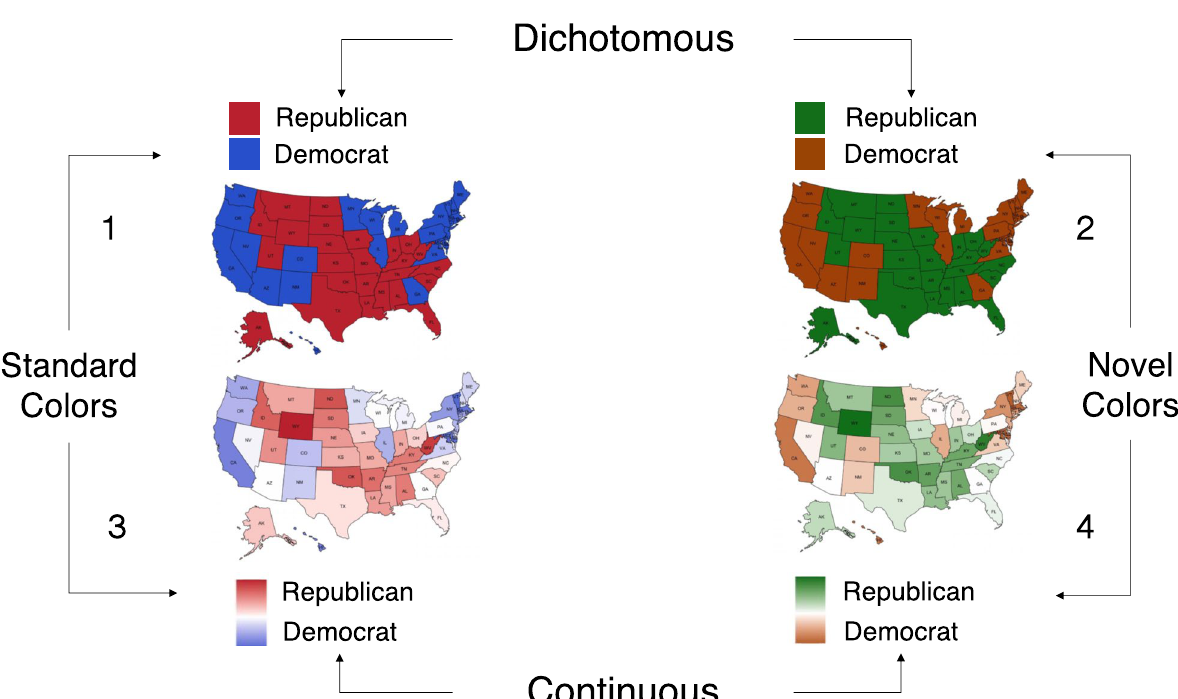
Fig. 5 Sample Study 2 Task stimuli for each of the four between-subject conditions: (1) red/blue dichotomous, (2) red/blue continuous, (3) orange/ green dichotomous, and (4) orange/green continuous. Within the four, hue varying conditions, the colors assigned to each state were randomized across participants, but the states were always divided evenly across the two hue categories. Participants completed 15 trials, which consisted of estimating fifteen randomly assigned States out of the total Fifty U.S. States. On each of the fifteen trials, the position of the line with the arrow identified which of the fifteen states the participant was judging. Note that the colors assigned to each state remained constant across a